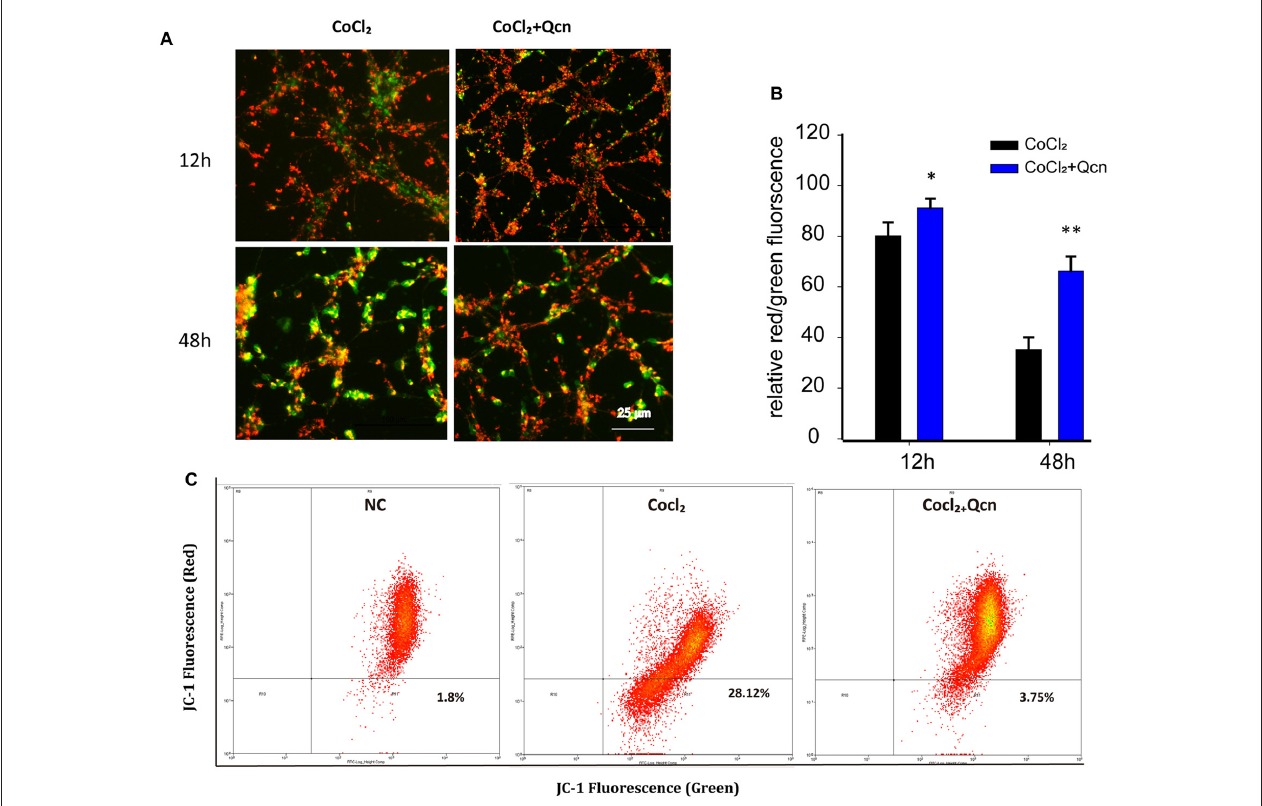
FIGURE 8 | (A) Representative images of JC-1 staining of RGCs with CoCl 2 and Qcn treatment for 12 h and 48 h. All images were captured at the same magnification. Scale bars, 100 µ m. (B) Quantitative analysis of the ∆ψ m by the ratio of the red and green fluorescence. The bars indicate the mean ± SD. ∗ p < 0.05 and ∗∗ p < 0.01 for the hypoxia+Qcn group compared with the hypoxia group. (C) Fluorescence density of J-aggregates ( y -axis) against JC-1 monomers ( x -axis) displayed in a dot plot.